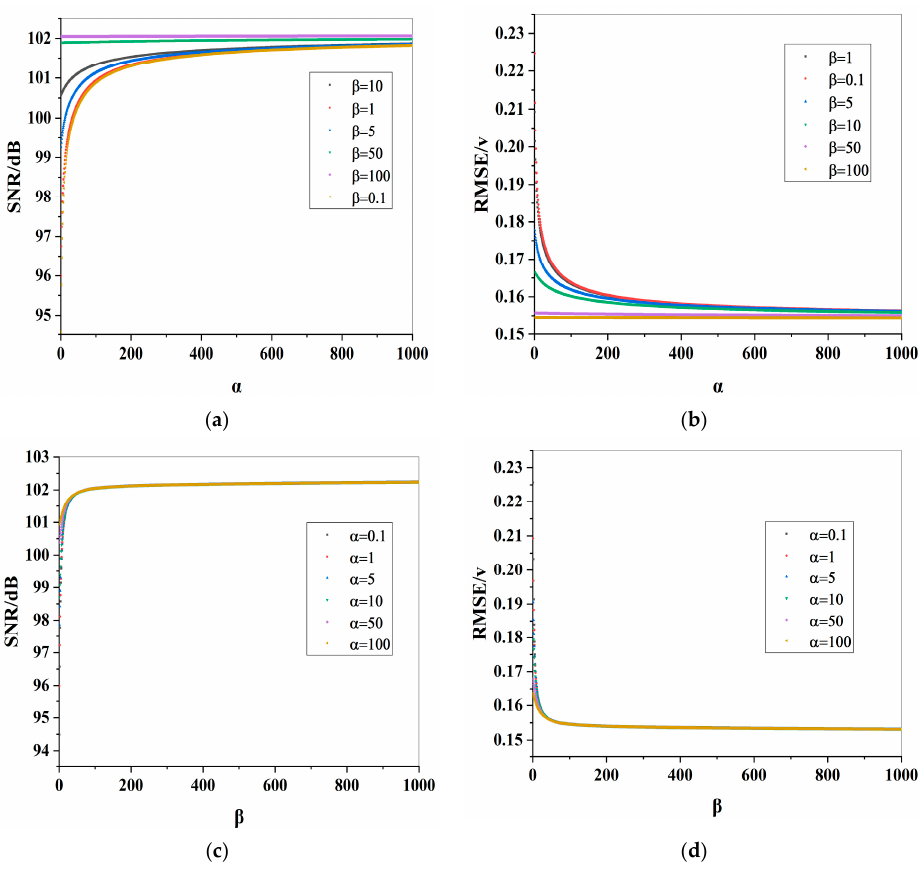
Figure 15. SNR and RMSE curves under different parameter values ( a ) SNR values under different α ; ( b ) RMSE values under different α ; ( c ) SNR values under different β ; ( d ) RMSE values under different β .